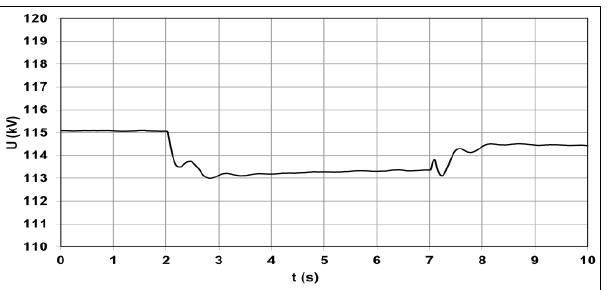
Figure 9. Changes in the voltage value in the receiving node, resulting from the farm operation in the frequency regulation mode.